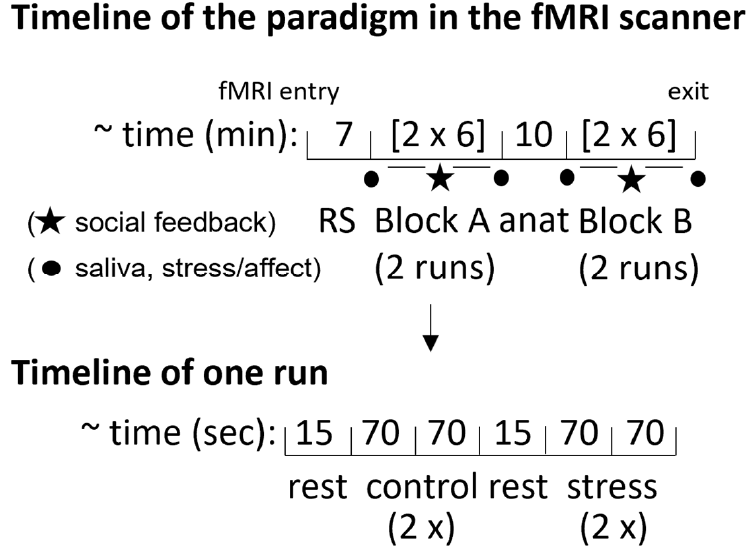
Figure 1. Timeline of the paradigm within the fMRI scanner and timeline for one run. Block A and Block B were either the non-regulation or the regulation block. The non-regulation and regulation blocks were presented in a randomized order across participants. A resting-state scan (RS) and an anatomical scan (anat) were assessed before Block A and Block B to adapt subjective arousal levels before each block.